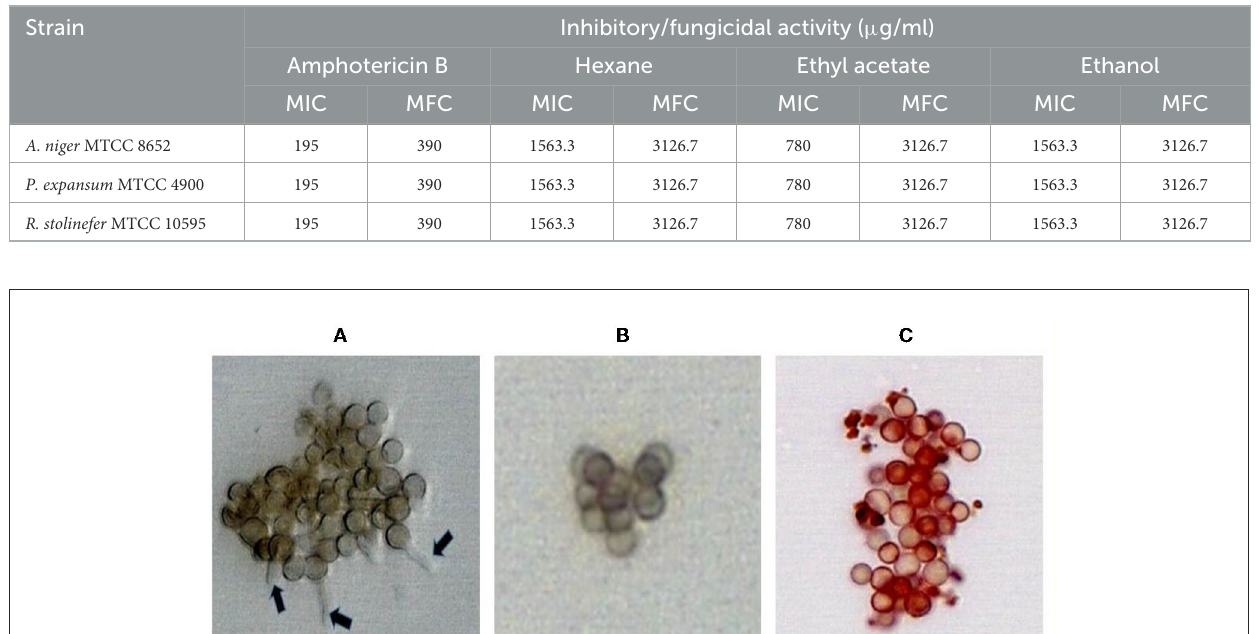
TABLE 2 M. purpureus pigment extracts’ MICs and MFCs for fungal pathogens.